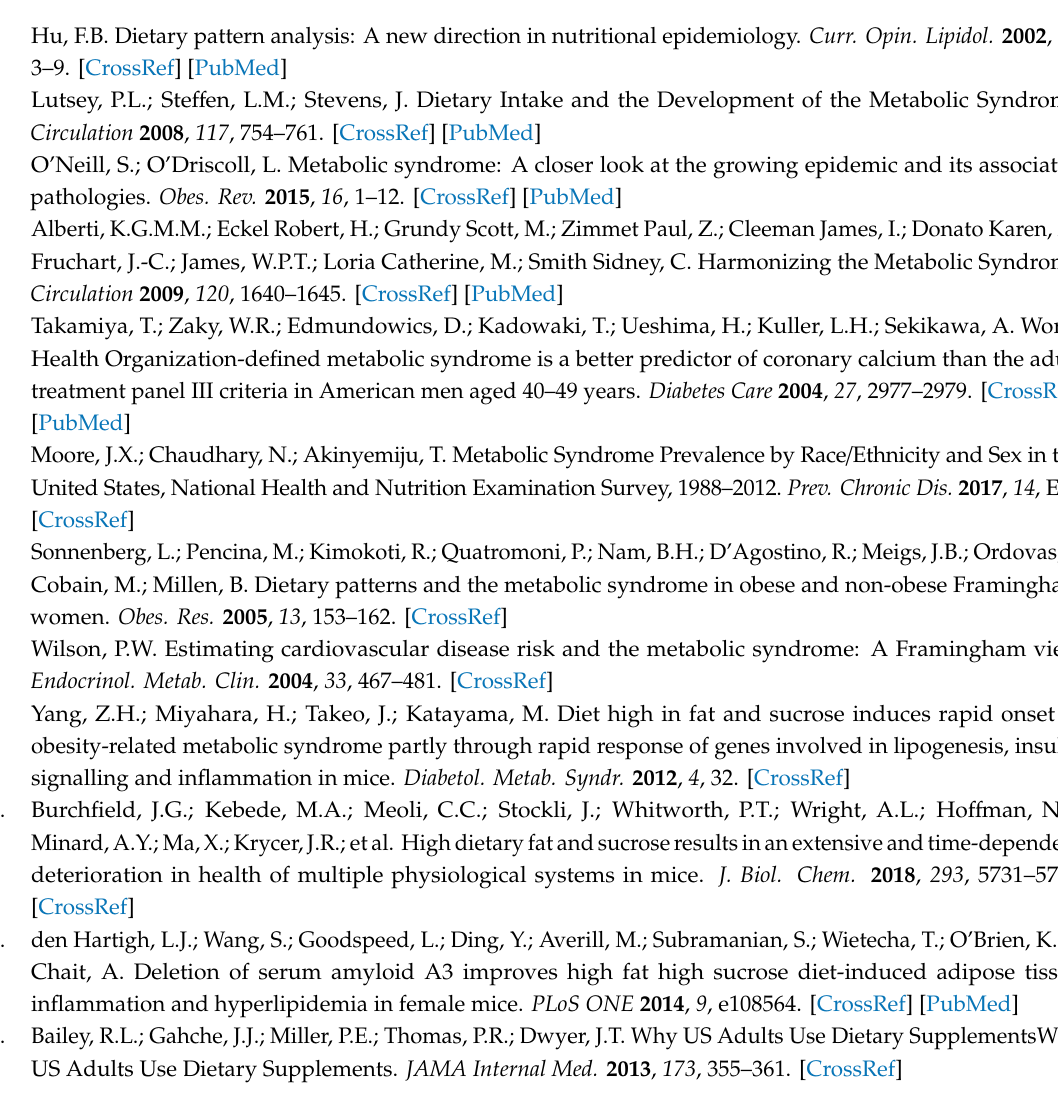
Figure S1: Correlation between RER and food quotient (FQ). Table S1: Custom HFS diet composition. Table S2: Antibody information. Table S3: Gene name and primer